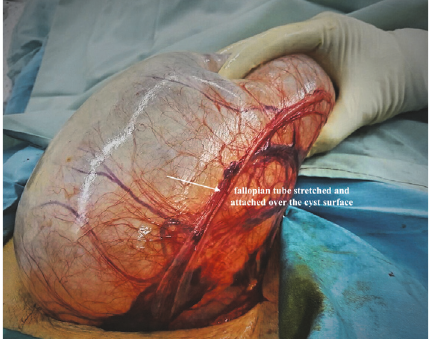
Figure 1: Left ovarian cyst (40 × 15 cm). Figure 2: The left fallopian tube: adherent and stretched over the cyst.